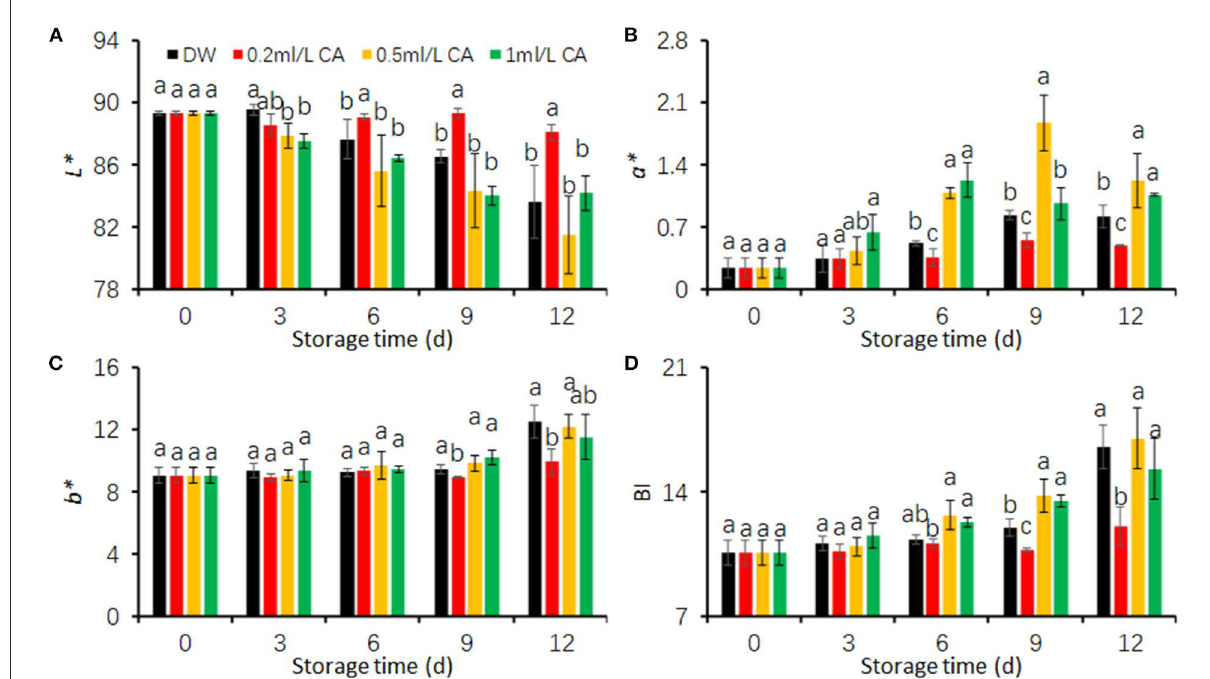
FIGURE1 Effects of different concentrations (0.2, 0.5, and 1 mL/L) of citronellal (CA) treatments on the browning of fresh-cut taros during cold storage. (A) L * value; (B) a * value; (C) b * value; (D) browning index (BI). Fresh-cut taros were stored at 5 ◦ C during the entire storage. DW, distilled water. Each value is presented as the mean ± SE ( n = 9). Statistical differences ( p ≤ 0.05) are indicated using different letters above the